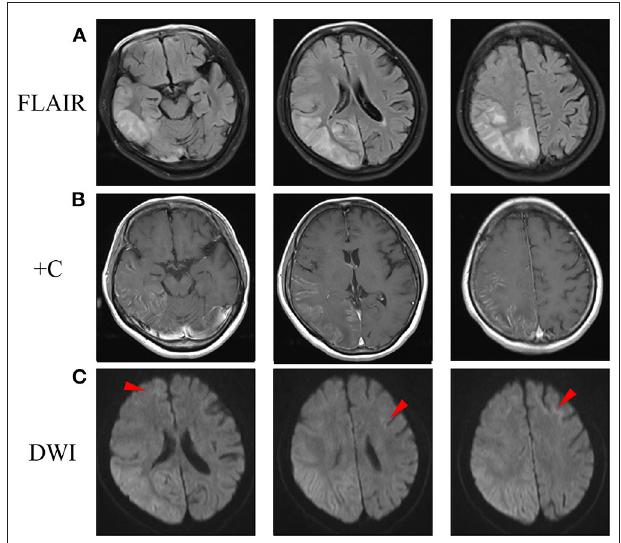
FIGURE 1 | Brain MRI scan after admission. (A) FLAIR images showed abnormal hyperintensity along the cortex and partial subcortical area in the right occipito-parieto-temporal lobes and a part of frontal lobe. (B) Post-contrast MRI showed enhanced lesions along the surface of the cortex. (C) DWI showed hyperintensity in the right cerebral and corticomedullary junction of anterior frontal lobes (arrowheads). DWI, diffusion-weighted image; FLAIR, fluid-attenuated inversion